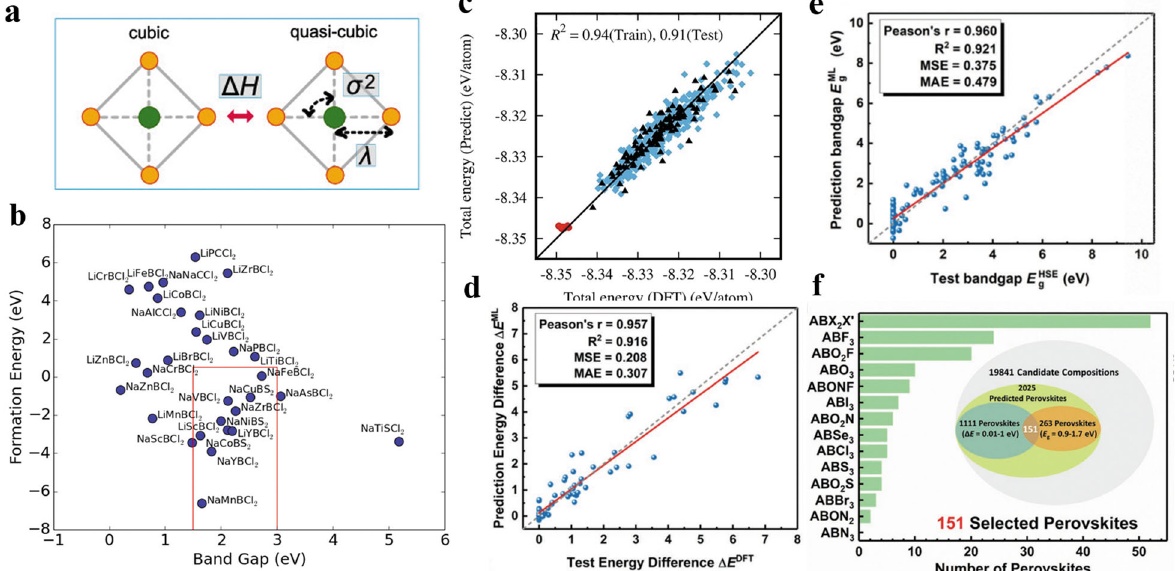
Fig. 6 Applications of ML in inorganic perovskites. a The parameters Δ H , λ , and σ 2 were used to quantify the distortion out of the ideal cubic perovskites 67 . b the formation energy and E g of predicted Li(Na)BX 3 perovskite with DFT. The perovskites in the red box have the ideal formation energy and E g values 69 . c Relationship between the total energy values for BaNbO 2 N supercells in the training set (rhombuses) and the test set (triangles) predicted by RR and the data calculated by DFT. Reproduced with permission from ref. 98 . Copyright Elsevier 2019 d The predicted phase-transition energy difference Δ E versus DFT calculations. Reproduced with permission from ref. 100 . Copyright John Wiley and Sons, Inc. 2019 e Comparison between test bandgap E HSE g and predicted bandgap E ML g . Reproduced with permission from ref. 100 .